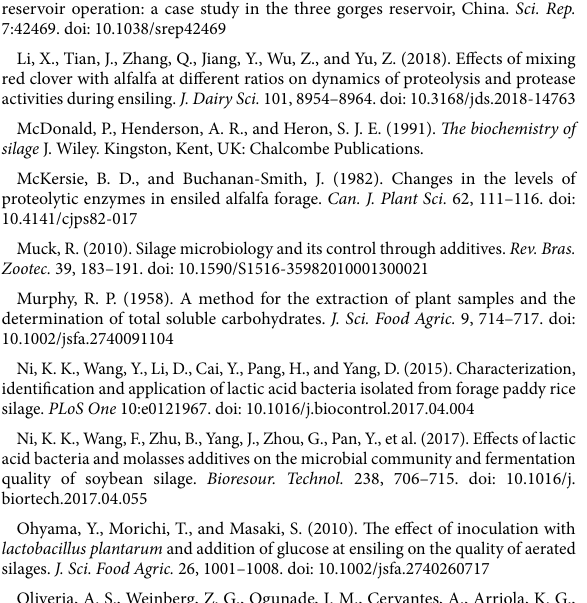
Tabacco, E., Piano, S., Cavallarin, L., Bernardes, T. F., and Borreani, G. (2009). Clostridia spore formation during aerobic deterioration of maize and